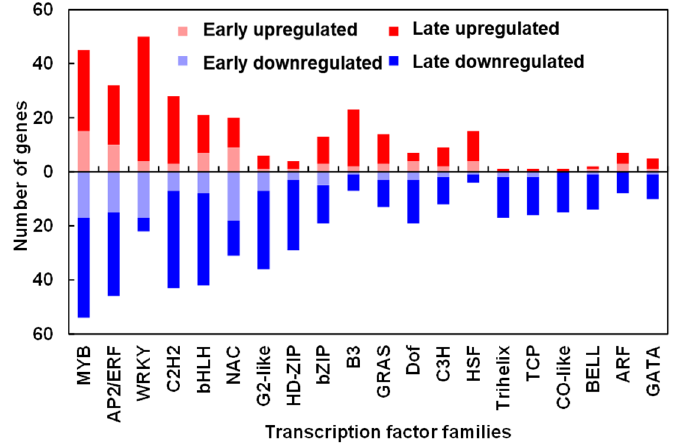
Figure 11. Summary of the top transcription factor families in the genes specifically responsive to 300 mg/L thidiazuron (TDZ) compared with 0.6 mg/L ethephon (TDZ-SRGs). Early: 3, 6, and 12 h after treatment; Late: 24 h after treatment. Red indicates upregulated expression and blue indicates downregulated expression.